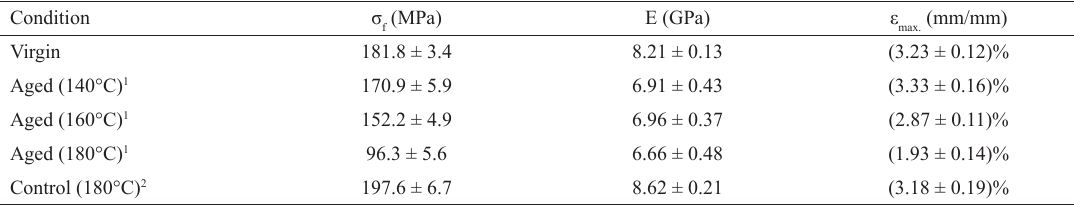
Table 2: Mechanical properties in bending test.